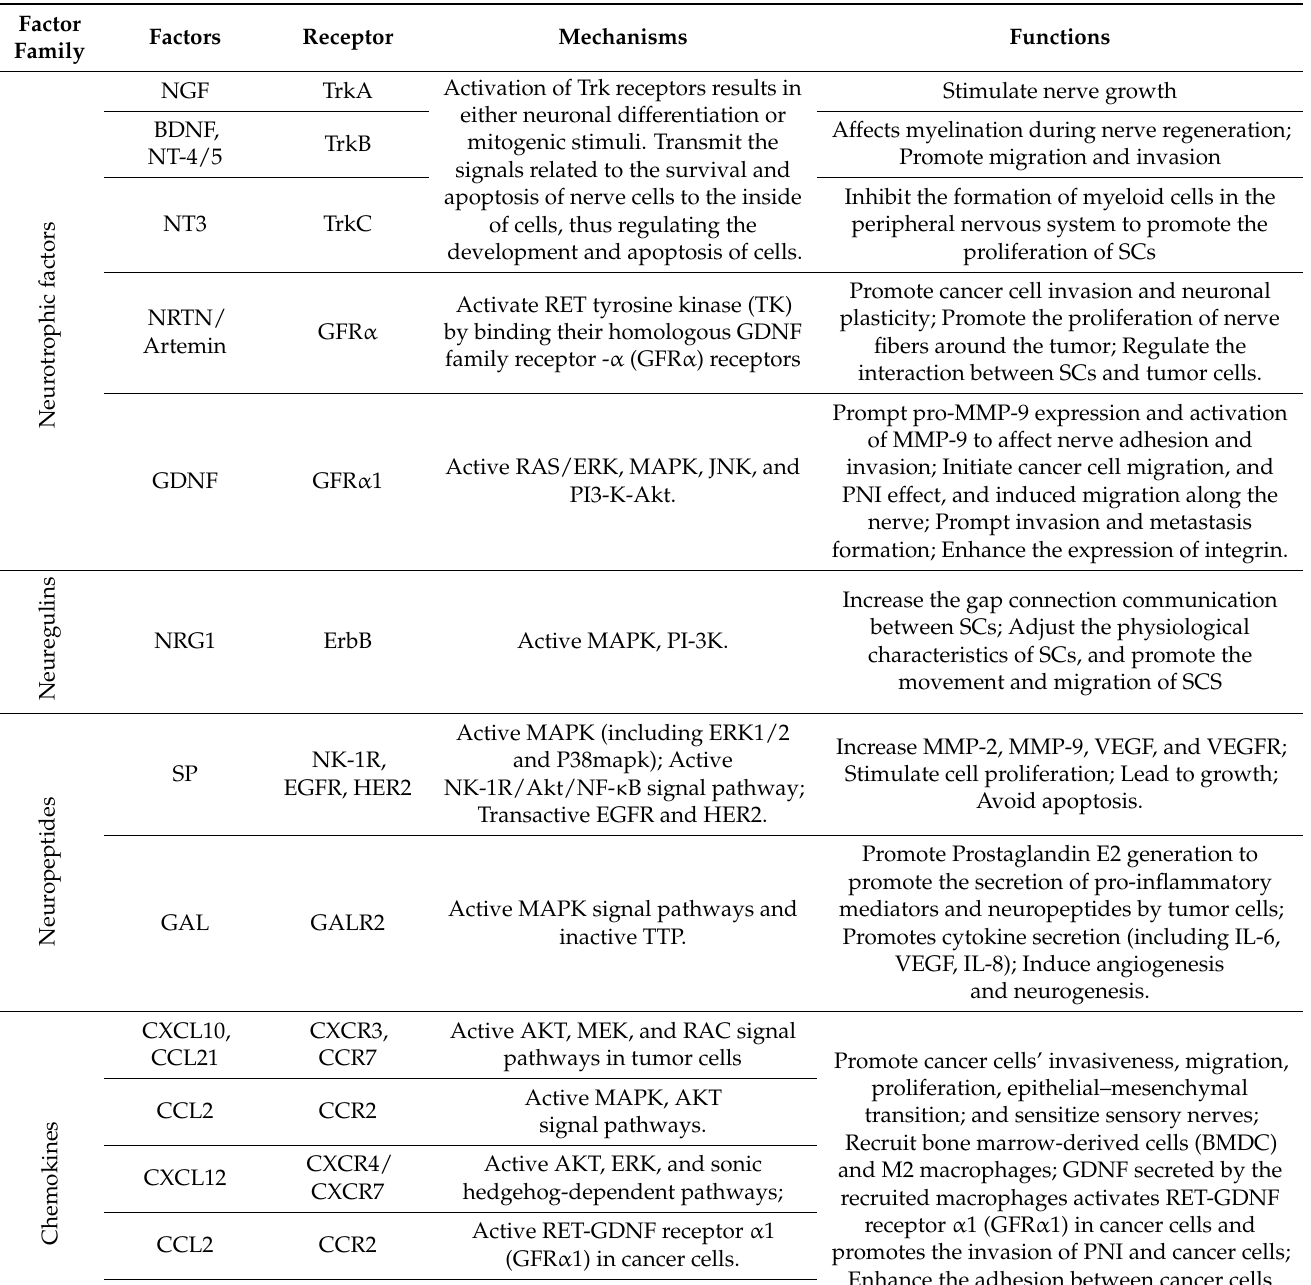
Table 1. Summary of factor function and its